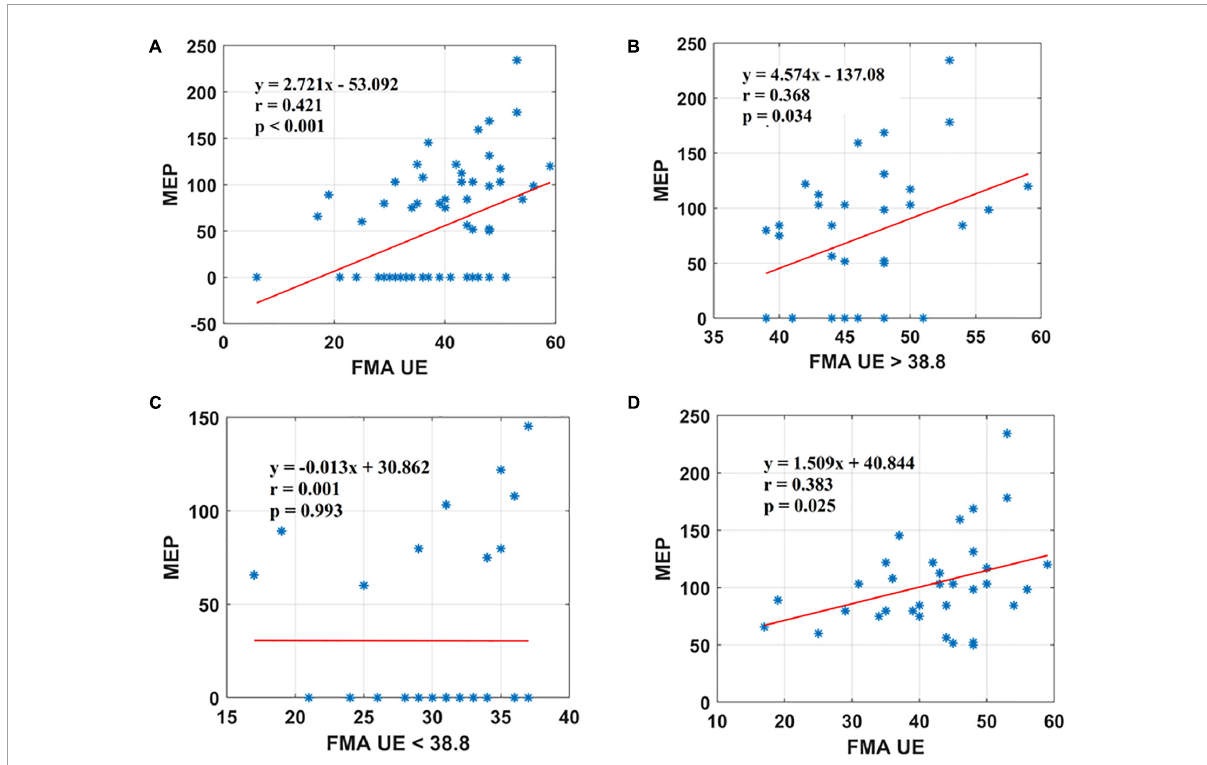
FIGURE2 Scatter plot showing the relationship between the (A) FMA UE scores and the MEP amplitude values for all the patients, (B) FMA UE scores > 38.8 and the MEP amplitude values obtained, (C) FMA UE < 38.8 and the MEP amplitude values, (D) FMA UE scores and the MEP amplitude values for all patients in MEP (+) group. *Represents the data of each